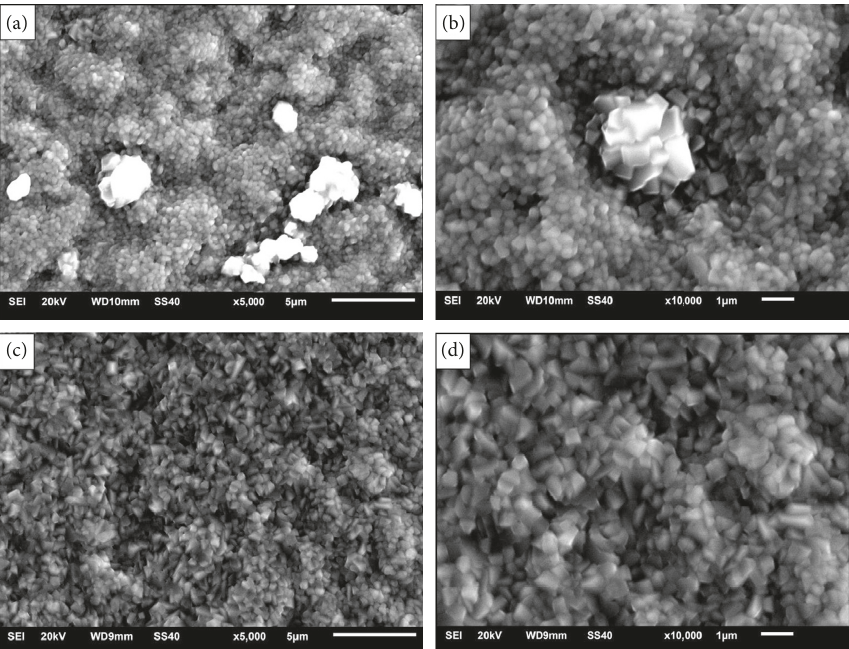
Figure 4: Surface morphology of Co-Mn 3 O 4 composite coating after oxidization for different times: (a) 10min, low magnification; (b) 10 min, high magnification; (c) 4h, low magnification; (d) 4 h, high magnification.